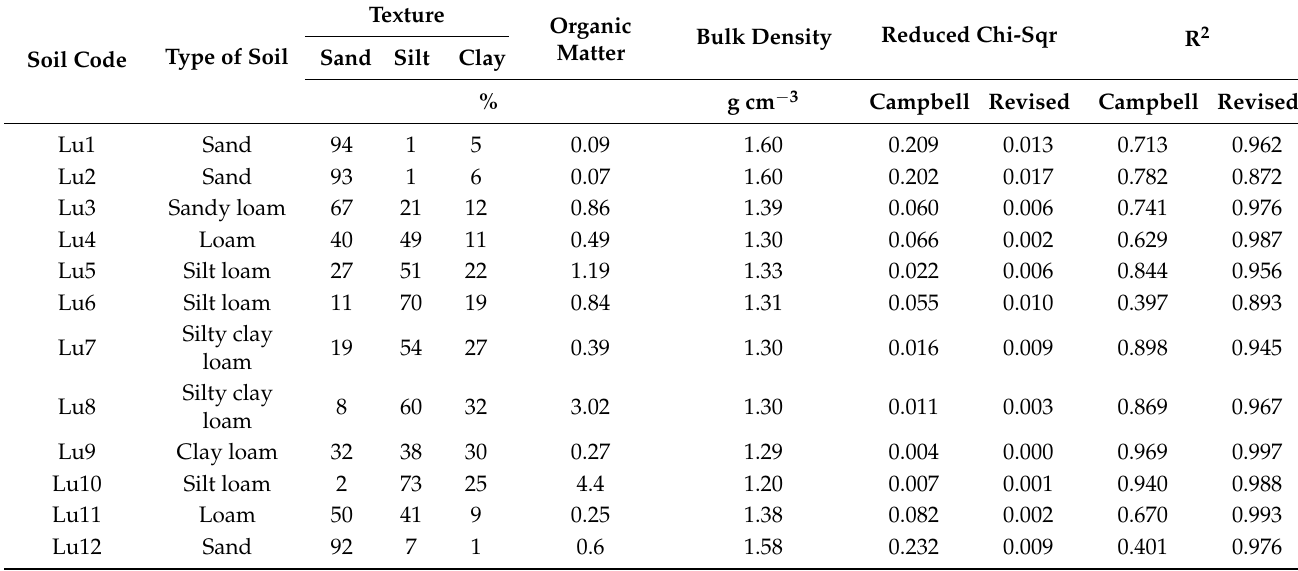
Table 8. Comparison of the reduced Chi-Sqr and R 2 of the Campbell model and the new model on the measured soil from Lu et al.